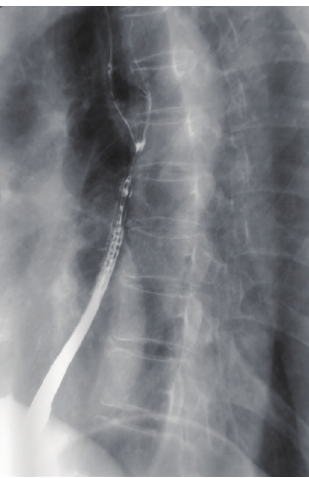
Figure 7 There is no manifestation of esophageal diverticulum on barium meal X-ray examination